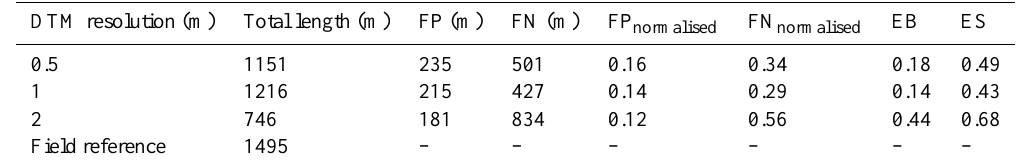
Table 2. Assessment of the extracted network of the Moulin catchment test area using the CI-based method with different DTM resolutions.